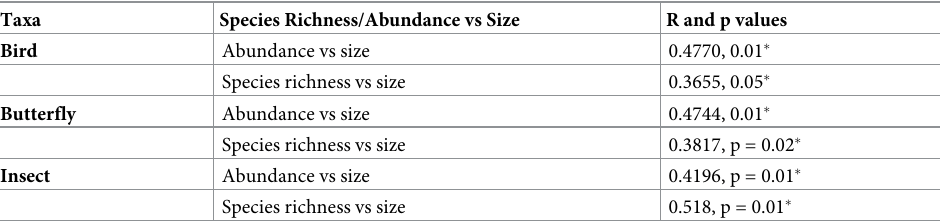
Table 1. Pearson’s correlation between species richness/abundance with size of NPs across